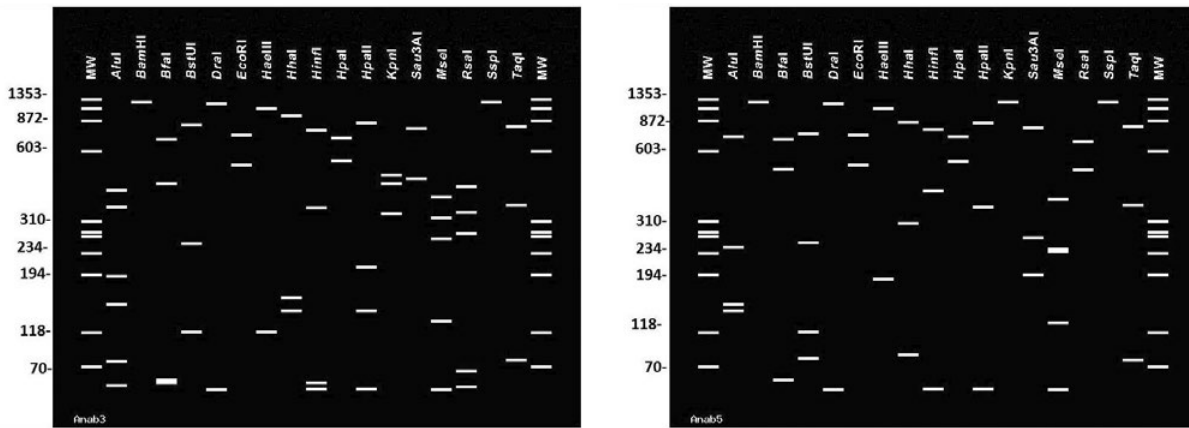
Figure 3. Virtual RFLP generated with program i PhyClassifier from in silico digestion of the R16F2n/R16R2 fragments of the (left) jujube yel- lowing (GenBank accession number MK379604) and (right) jujube witches’ broom phytoplasma (GenBank accession number